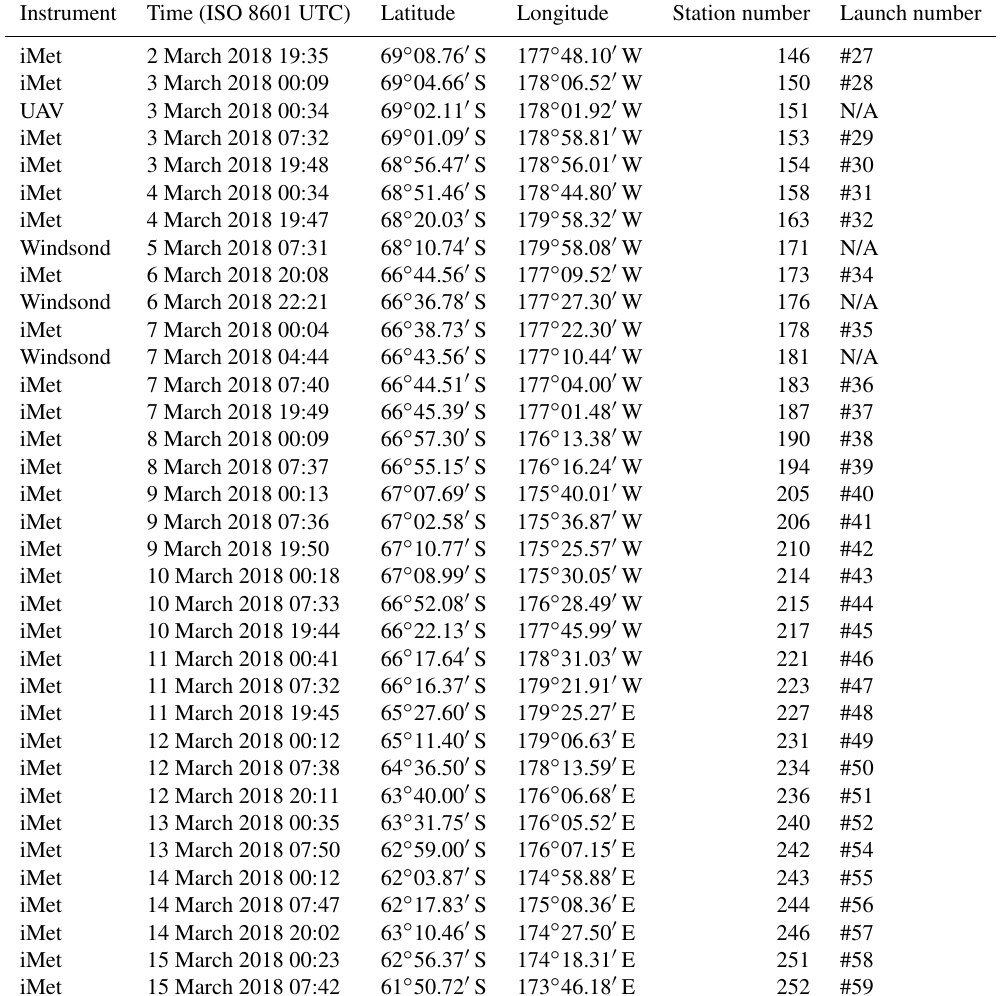
Table B2. Release date, time, and location of all radiosondes releases as well as Helikite and UAV flights (continued). Instrument Time (ISO 8601 UTC) Latitude Longitude